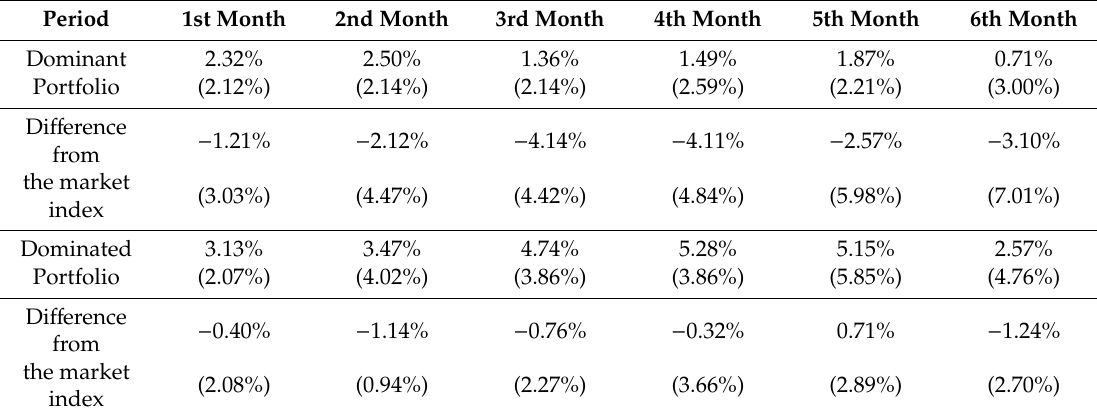
Table 5. Bullish period (2005: 4–2005: 9) returns after formation.